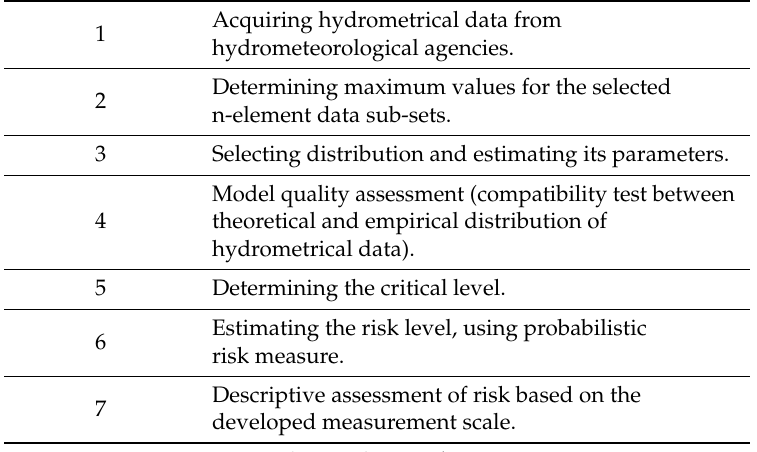
Table 1. Methodological path of probabilistic quantification in analysis of flood